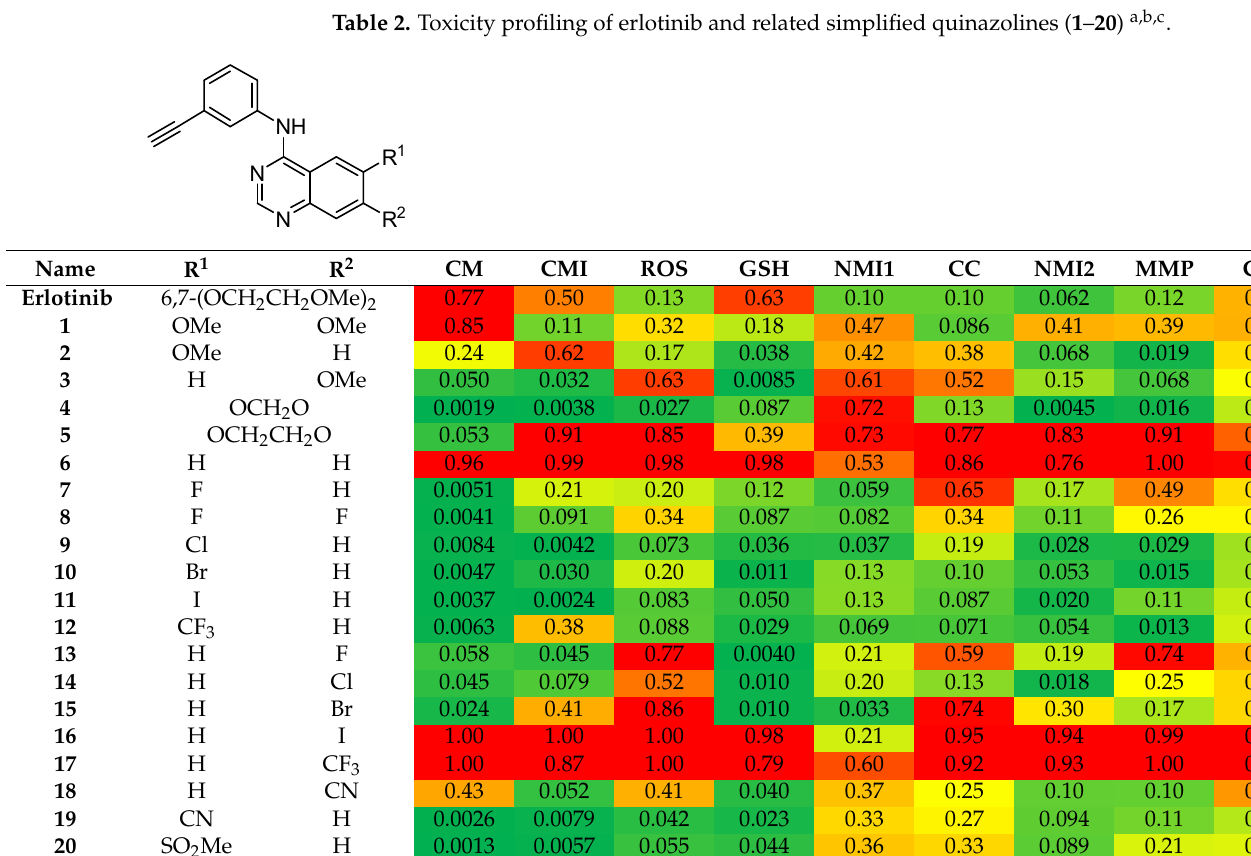
Table 2. Toxicity profiling of erlotinib and related simplified quinazolines ( 1 – 20 ) a,b,c .